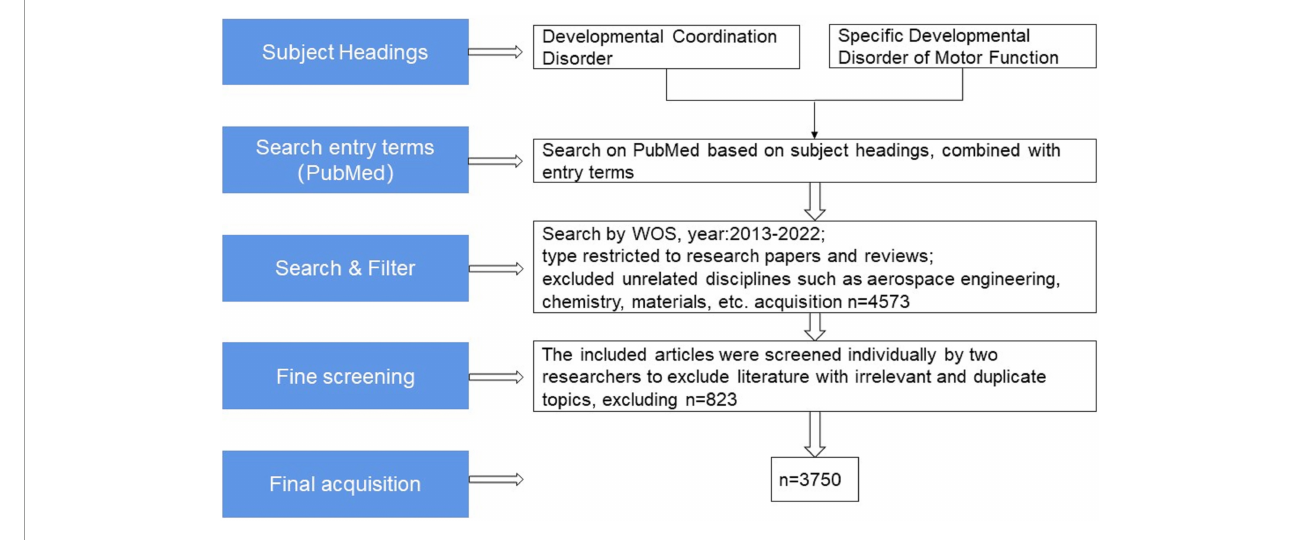
FIGURE1 Data acquisition and entry process.